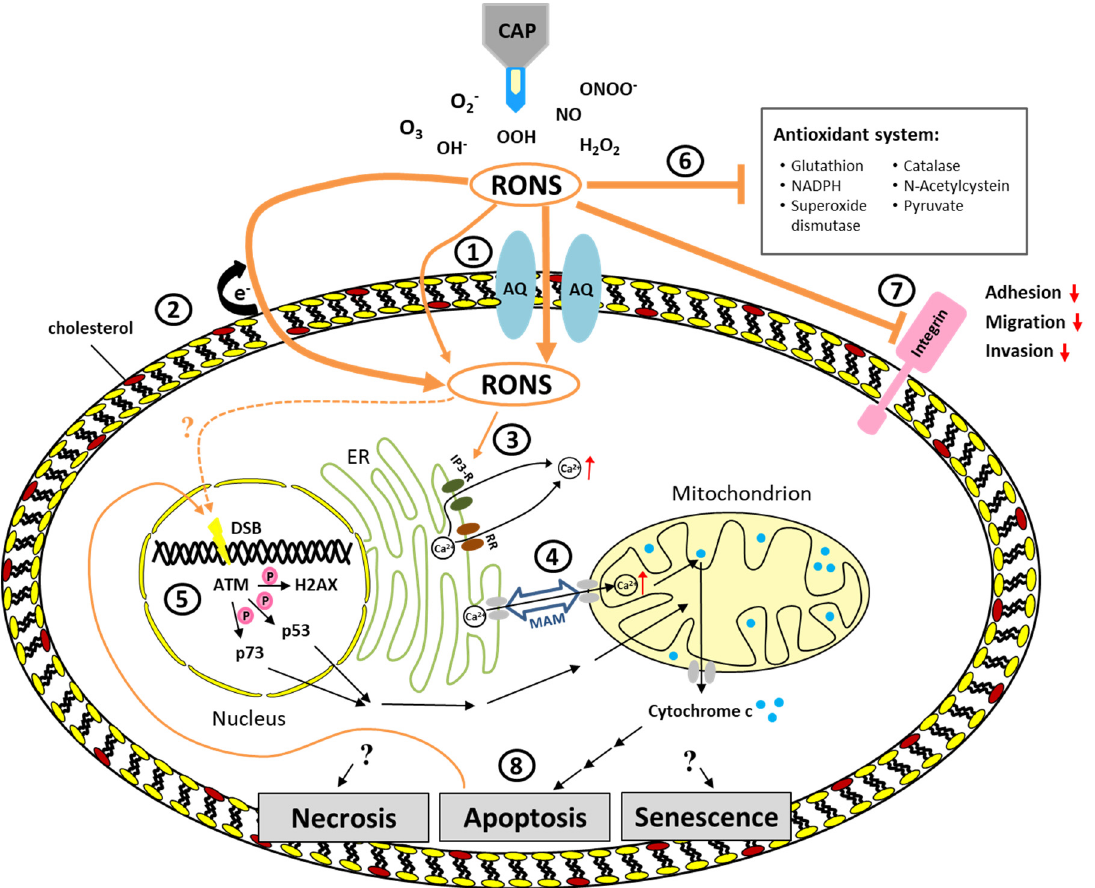
Figure 1. Overview of the current understanding of molecular mechanisms involved in the e ffi cacy of cold atmospheric pressure plasma (CAP) in cancer treatment 1 (cid:79) Aquaporins (AQ), often increased in cancer cells, facilitate transition of reactive oxygen and nitrogen species (RONS) into the cell, while minimal amounts may also di ff use through the cell membrane. 2 (cid:79) Lipid peroxidation by free radicals leads to pore formation in the membrane and hence facilitates di ff usion of reactive species into the cell. This e ff ect may be enhanced in cancer cells due to reduced levels of cholesterol-a lipid important for providing membrane stability and fluidity. 3 (cid:79) Increased intracellular RONS interfere with calcium signaling (e.g., through interaction with inositol trisphosphate receptor [IP3-RR] and ryanoid receptor [RR]) resulting in increased calcium influx into cytosol. 4 (cid:79) Furthermore, RONS induced endoplasmic reticulum (ER) stress leads to a calcium influx into mitochondria reducing the membrane potential and hence inducing mitochondria-dependent apoptosis. 5 (cid:79) CAP induced DNA double strand breaks (DSB) cause a DNA damage response including activation of ATM, H2AX, p53, and p73. These DSB may not be a direct e ff ect of CAP on DNA but rather a consequence of CAP induced apoptosis. 6 (cid:79) Increased levels of RONS produced by CAP overwhelm the antioxidant system and hence limit its protective e ff ect against oxidative stress. 7 (cid:79) Reduced expression of integins after CAP treatment may explain the reduction of adhesion, migration, and invasion after CAP treatment. 8 (cid:79) As a consequence of CAP treatment necrosis, apoptosis, and senescence have been reported. Which of these processes is induced seems to be dose-dependent. However, the underlying mechanisms that decide which process of growth arrest or cell death as a consequence of CAP treatment is triggered still need to be further elucidated. MAM = mitochondria-associated ER